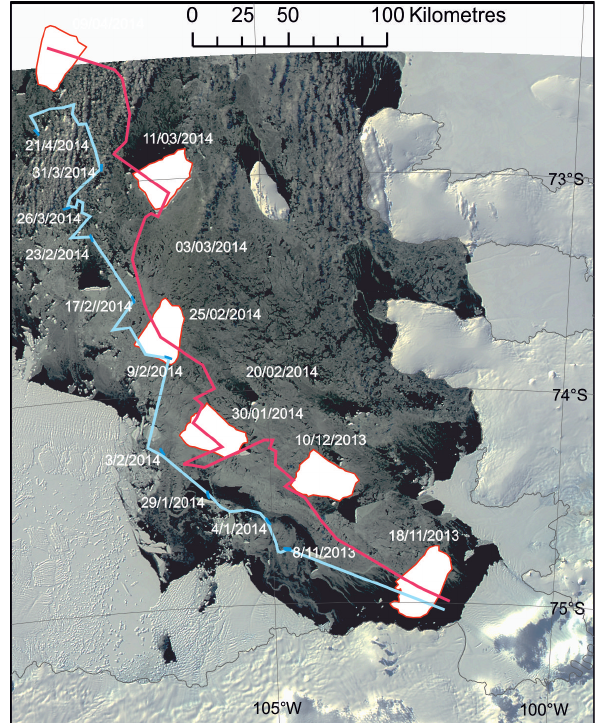
Figure 11. Tracks generated from ADIOS units situated on B-31 iceberg. Iceberg outlines derived from Radarsat2 SAR (courtesy of MacDonald Dettwiler and Associates – MDA Corporation) and MODIS optical (courtesy of NASA) satellite